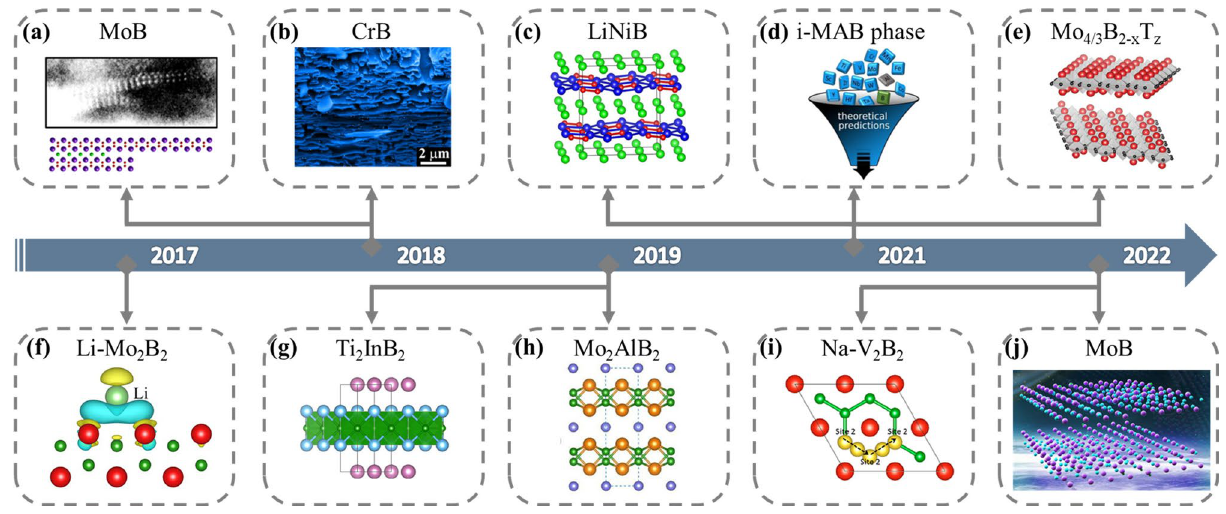
Fig. 2 The representative historical timeline of MBene. a Magnification image of the cavity containing the MoB sheets with idealized structure of the delaminated region of the MBene sheets. Reproduced with permission from Ref. [87]. b Microstructure of 2D CrB nanosheets prepared by etching for 8 h in dilute HCl solution. Reproduced with permission from Ref. [88]. c Crystal structure of RT -LiNiB. Reproduced with per- mission from Ref. [89]. d Chemical ordering upon metal alloying of M 2 AlB 2 (M from groups 3 to 9) in orthorhombic and hexagonal symmetry with first principles study. Fifteen stable novel phases with in-plane chemical ordering are identified, coined i-MAB. Reproduced with permis- sion from Ref. [82]. e The single-layer 2D molybdenum boride sheets with ordered metal vacancies, Mo 4/3 B 2-x T z (where T z is fluorine, oxygen, or hydroxide surface terminations). Reproduced with permission from Ref. [83]. f The first calculated charge density differences of Mo 2 B 2 with one Li atom adsorbed. Reproduced with permission from Ref. [86]. g Crystal structure of stable boron-containing ternary phase Ti 2 InB 2 . Repro- duced with permission from Ref. [90]. h The synthesis of Mo 2 AlB 2 from MAB phase MoAlB by treatment with LiF/HCl. Reproduced with permission from Ref. [91]. i Top view of the Na diffusion path for V 2 B 2 indicated by the black dotted arrows. Reproduced with permission from Ref. [84]. j 2D MoB MBene from the reaction between MoAlB and NaOH with a fluorine-free hydrothermal-assisted alkane solution etching method. Reproduced with permission from Ref.